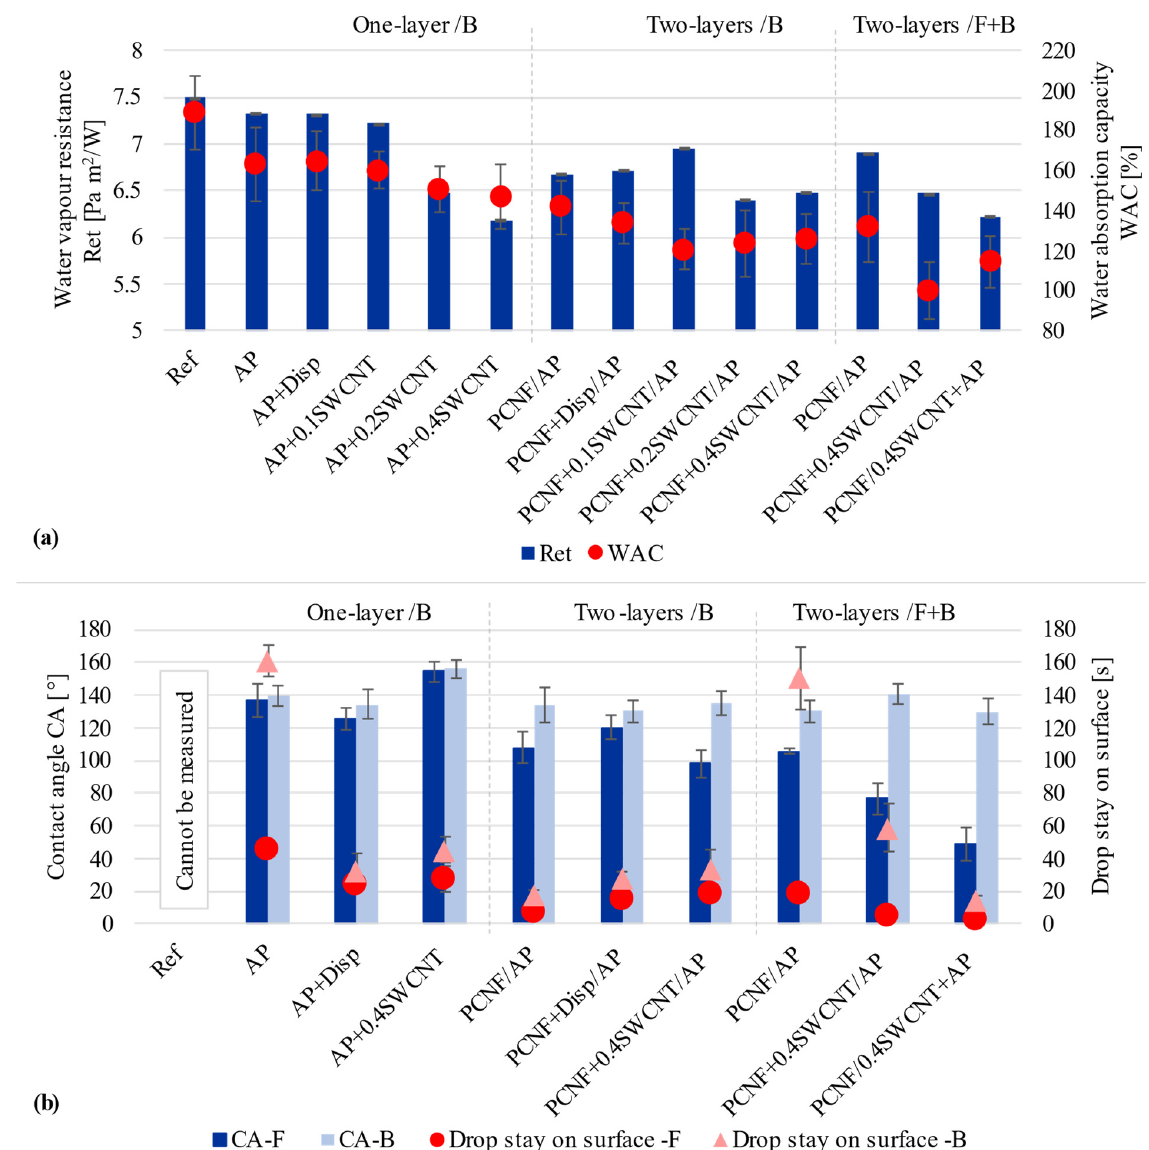
Figure 4. The effect of printing on the fabric’s: ( a ) Water vapour resistance determined on the front/F side and Water absorption capacities, and ( b ) Values of the Contact Angle (CA) and duration of the water droplet’s stay on the sample’s surface, measured on the fabric`s front/F and back/B sides.